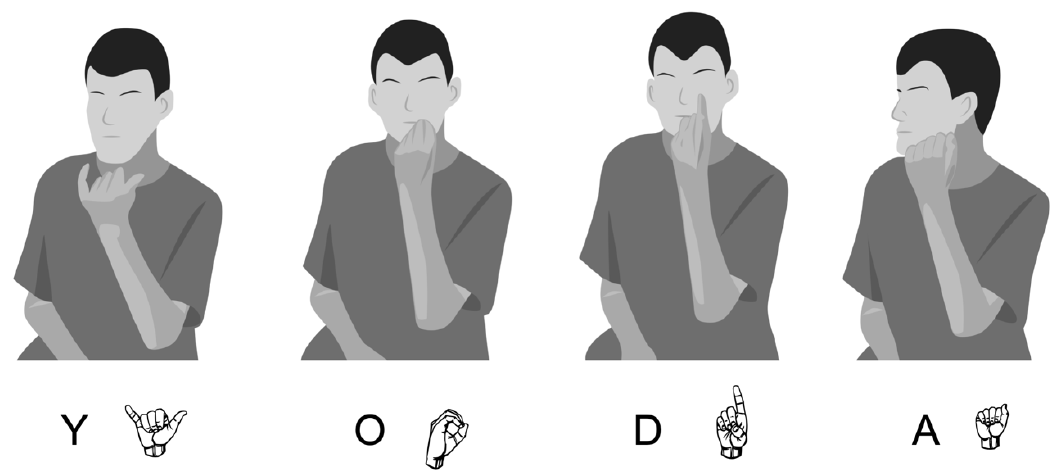
Figure 3. The fingerspelled word #YODA produced with reversed, inward palm orientation on each handshape at 14;11. The word was produced rapidly and fluently, unlike the labored production of #FATHER in Figure 4.